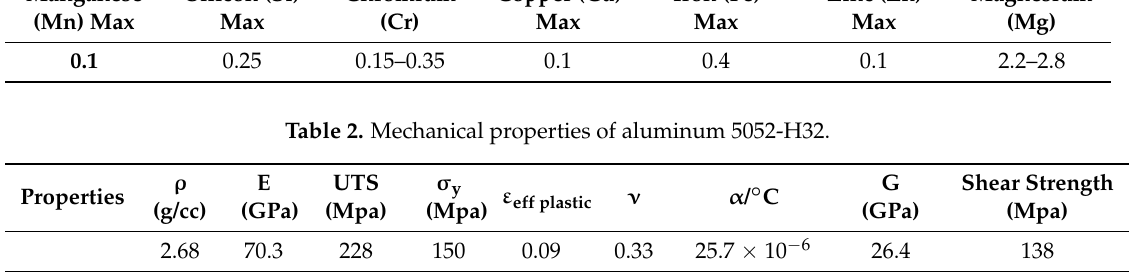
Table 1. Chemical composition of aluminum 5052-H32 alloy [38].